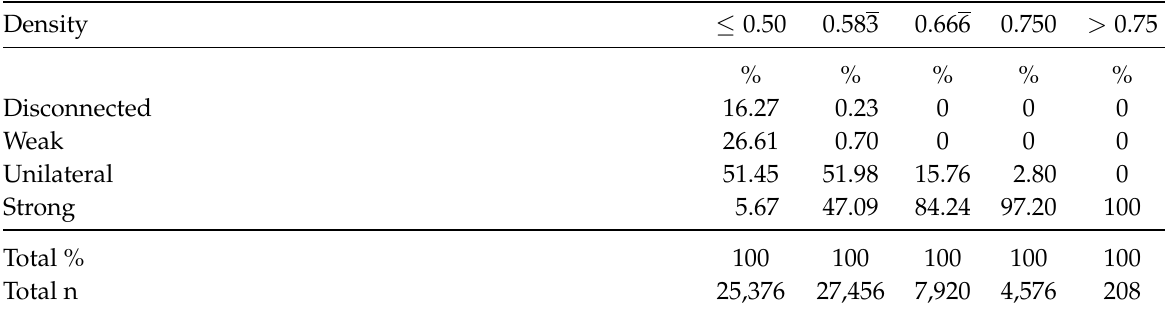
Table 6: Network density constraints on the distributions of network connectivity categories in n = 4 groups in the population of all possible 2 16 = 65, 536 directed